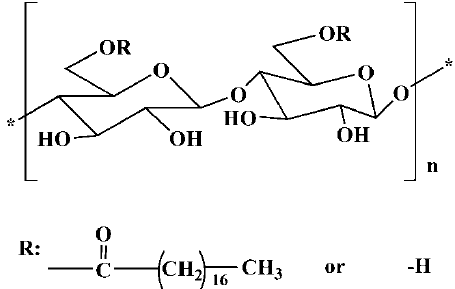
Figure 1. Chemical structure of stearic acid-modified Bletilla striata polysaccharides (BSPs-SA).